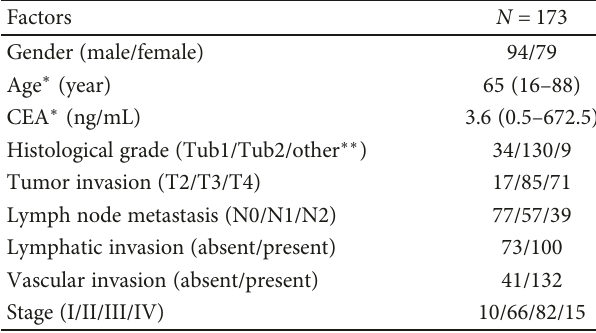
Table 1: Patient